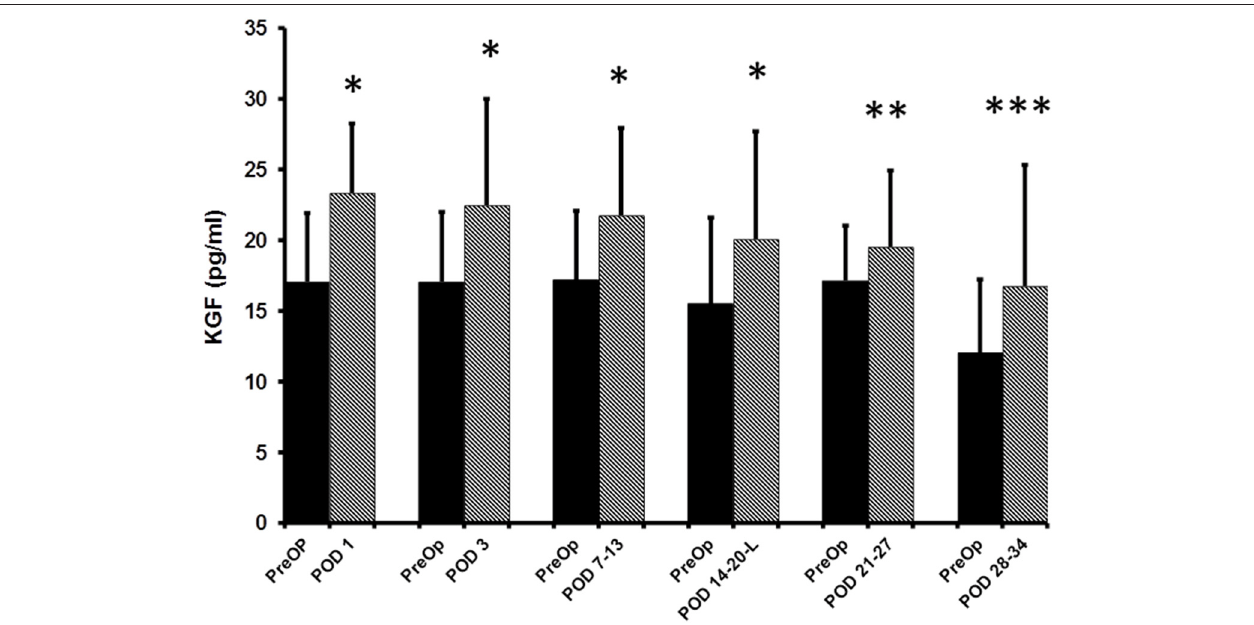
FIGURE 1 | ELISA determined pre-operative (Pre-op) and post-operative plasma KGF levels of colorectal cancer patients. KGF levels are expressed as median and 75% quartile range. * Pre-op vs. POD 1 ( n = 80, p < 0.0001); * Pre-op vs. POD 3 ( n = 76, p < 0.0001); * Pre-op vs. POD 7-13 ( n = 50, p < 0.0001); *Pre-op vs. POD 14–20 ( n = 33, p < 0.0001); ** Pre-op vs. POD 21–27 ( n -15, p = 0.03); *** POD 28–34 time point ( n = 12, p = 0.001).